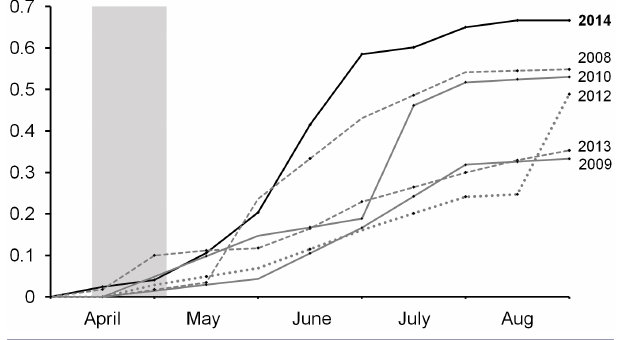
Fig. 3 . Five of the seven filmed chicks that were attacked by mice died outright from their wounds within 3.9 ± 1.2 days of the first attack. Here the parents return to feed their chick to find it has died since their last visit.